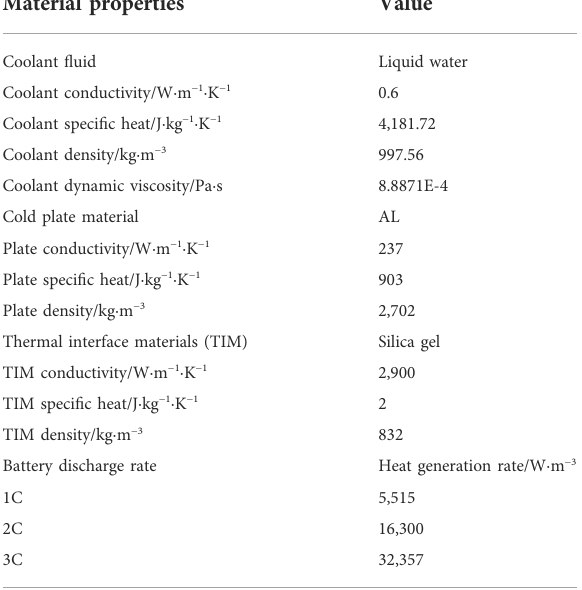
TABLE 3 Parameters setting of cooling